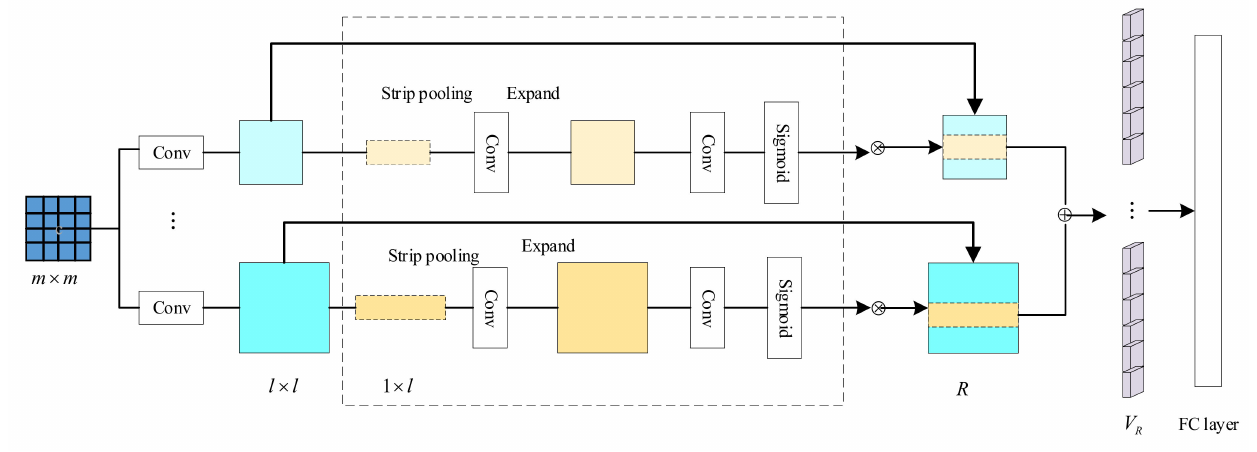
Figure 3. Structure of SMP module.